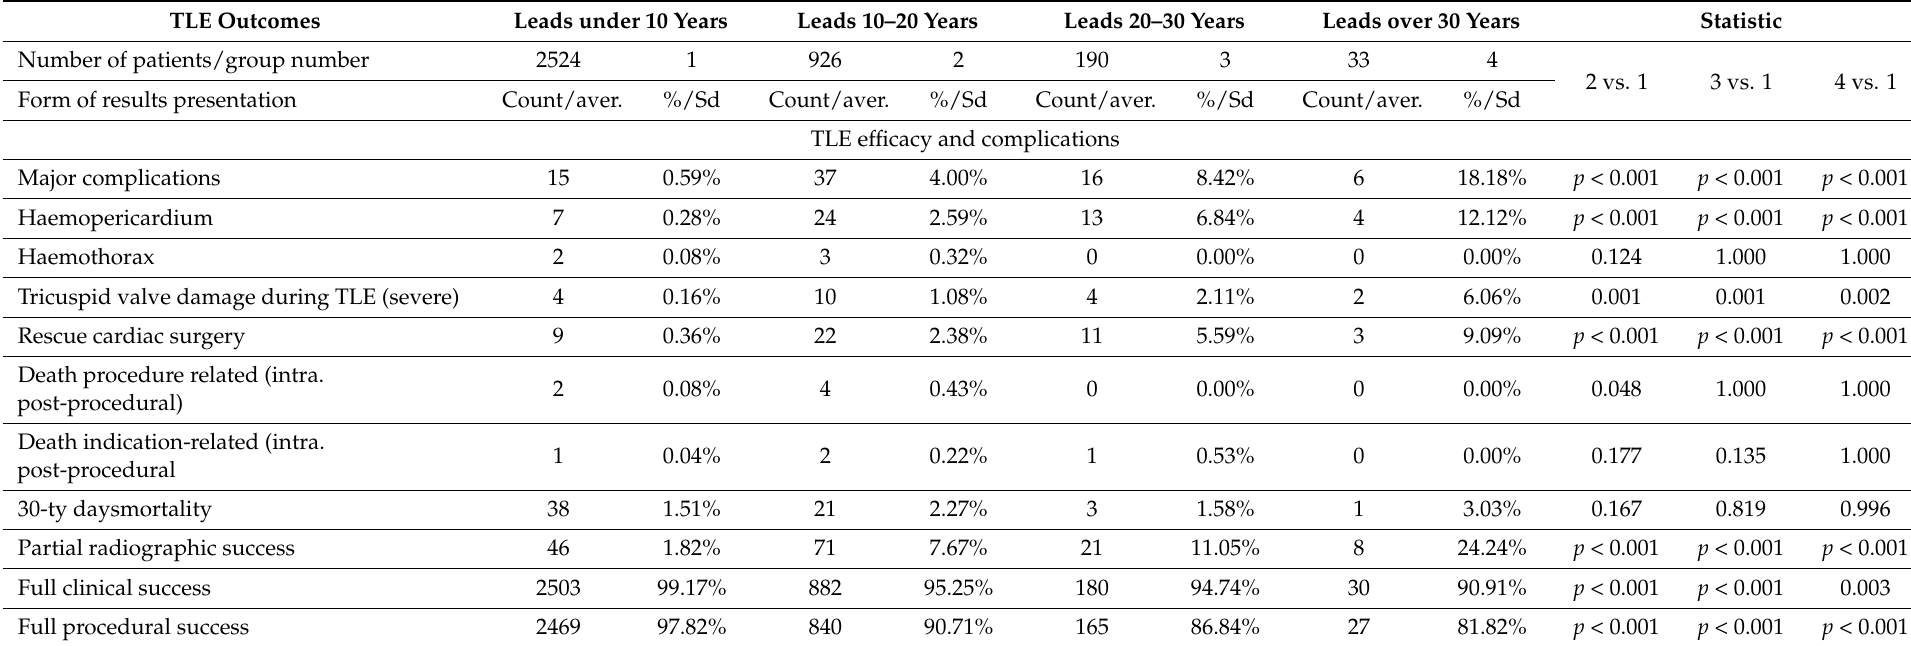
Table 4. TLE outcomes in different implant duration